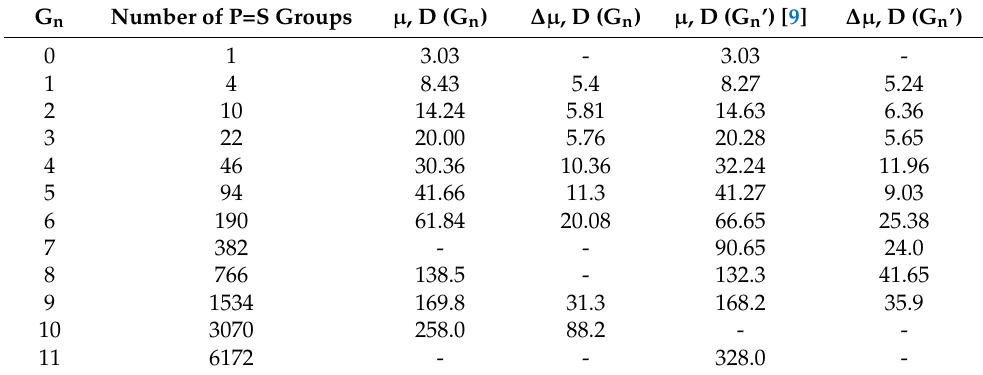
Table 1. Analysis of dipole moments of molecules of phosphorus-containing dendrimers.